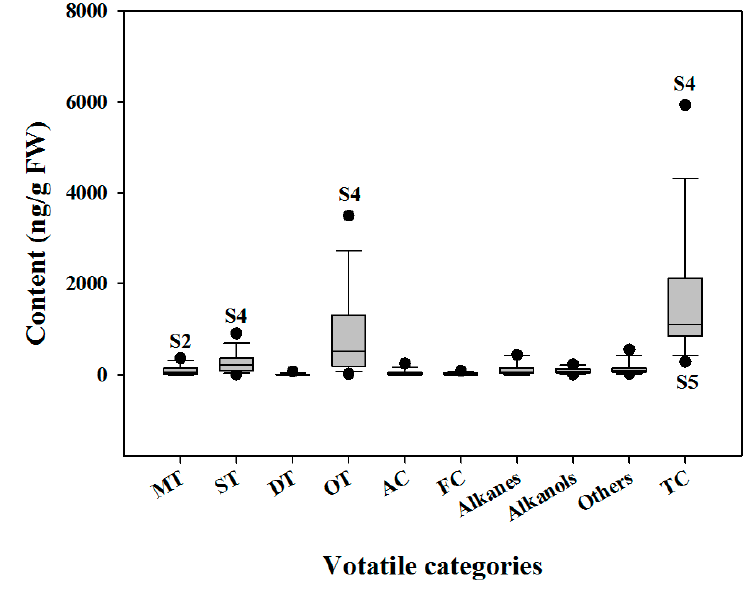
Figure 2. Box plot of the volatile constituents in the leaves of 14 samples. Sample numbers are the same as in Table 2. The abscissa indicates the compound contents of each samples expressed as the mean values of three biologic replicates. The ordinate indicates the volatile categories: MT, monoterpenes; ST, sesquiterpenes; DT, diterpenes; OT, oxygenated terpenes; AC, aromatic compounds; FC, fluorinated compounds; TC, total compounds. Table 2. Compositae plants used in this